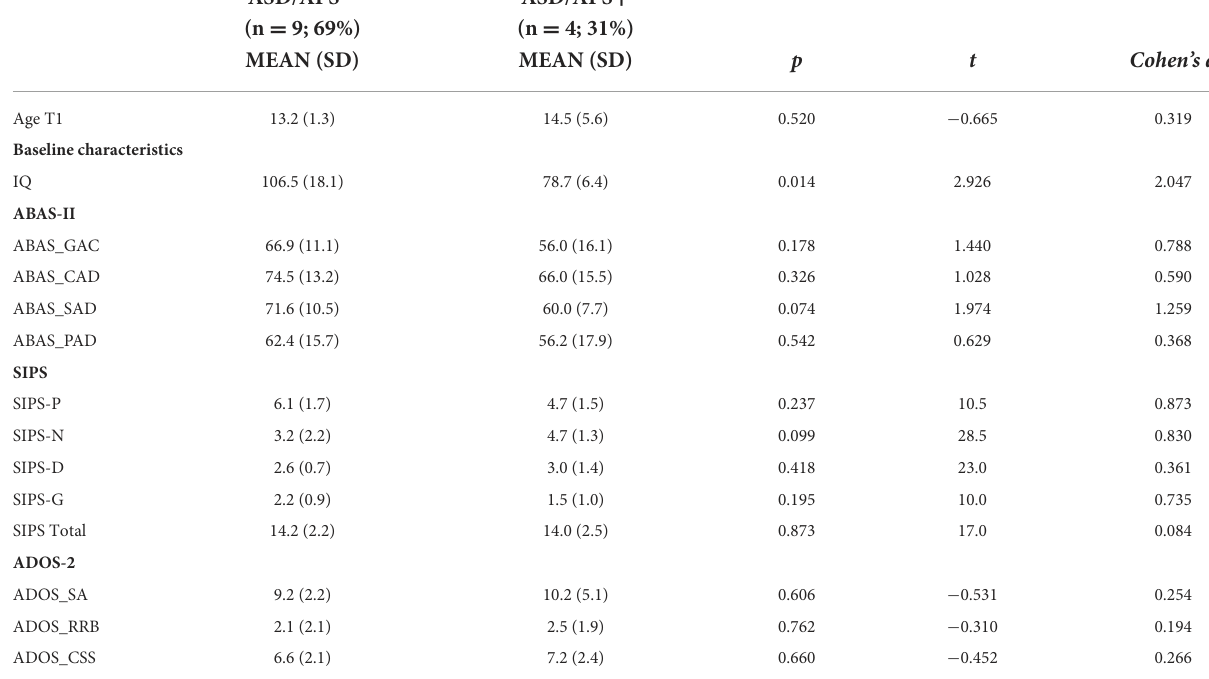
TABLE 2 ASD/APS- vs. ASD/APS+ sample